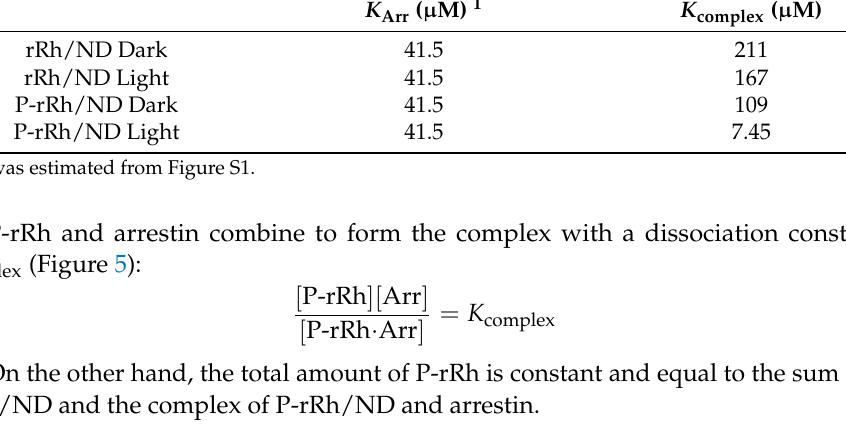
Table 1. Dissociation constants of the arrestin tetramer and the rhodopsin/arrestin complex. K Arr ( µ M) 1 K complex ( µ M) rRh/ND Dark